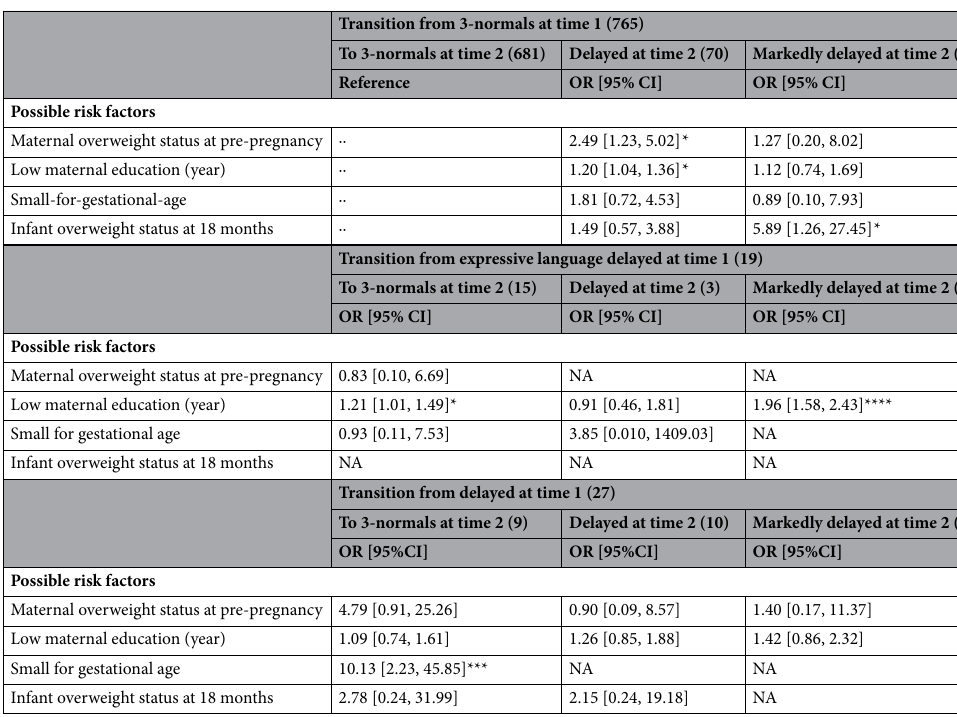
Table 3. Association between possible risk factors and neurodevelopmental transition patterns in the final model of multinomial logistic regression analysis with covariates ( n = 811). Infant’s sex (male), premature birth (< 37 weeks), low placenta-to-birthweight ratio (< 10th percentile), and household income. Fifty infants who had missing values for infant’s sBMI at 18 months and 14 mother-infant dyads who had missing values for mother’s placental weight were excluded from this analysis. OR odds ratio, CI confidence interval, NA not available. *P < 0.05, ***P < 0.005, ****P < 0.001.